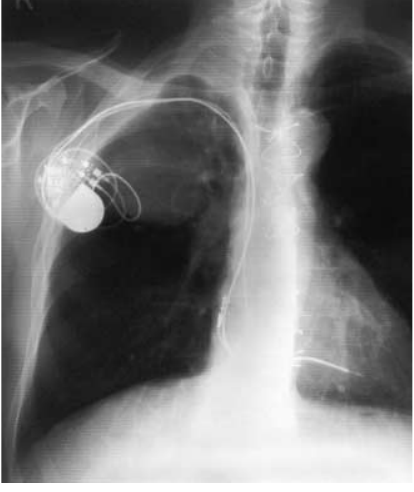
Figure 1 Chest X-ray showing a large mass in the right upper hemithorax. The lateral pleuro-pul- monary interface is obscured by a pacemaker device. Lateral view, however, showed clearly the pleural origin of the mass (image not shown).